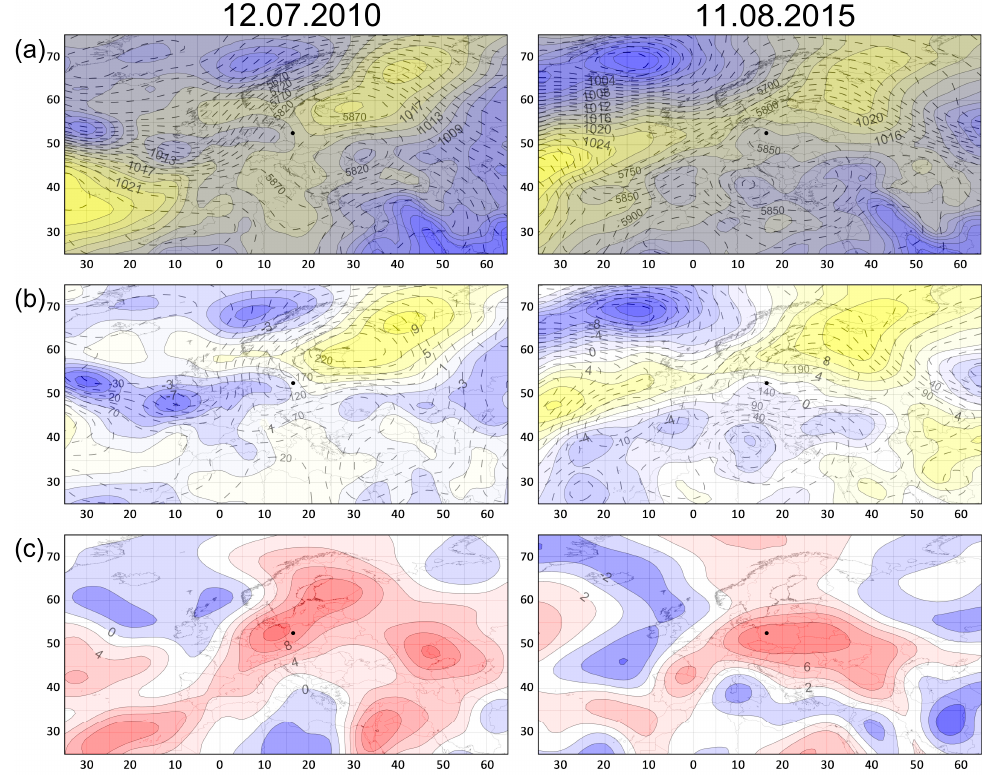
Figure 10. SLP and z500 hPa ( a ), SLP and z500 hPa anomalies ( b ) and T850 anomalies ( c ) on 12 July 2010 ( right column ) and 11 August 2015 ( left column ).